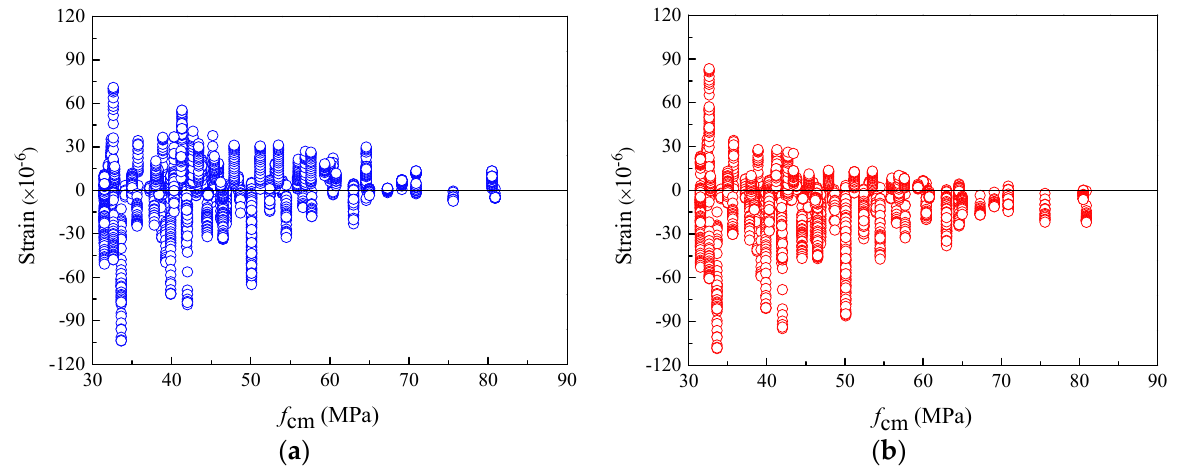
Figure 6. The residuals of creep compliance for CEB-FIP models versus f cm. ( a ) Residuals for CEB- FIP 1990 model. ( b ) Residuals for CEB-FIP 2010 model.